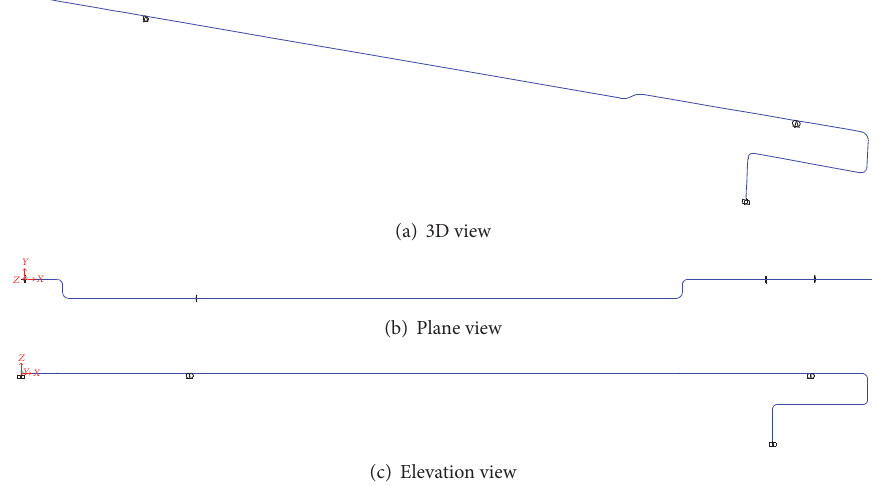
Figure 1: Nuclear power plant piping system for earthquake analysis.